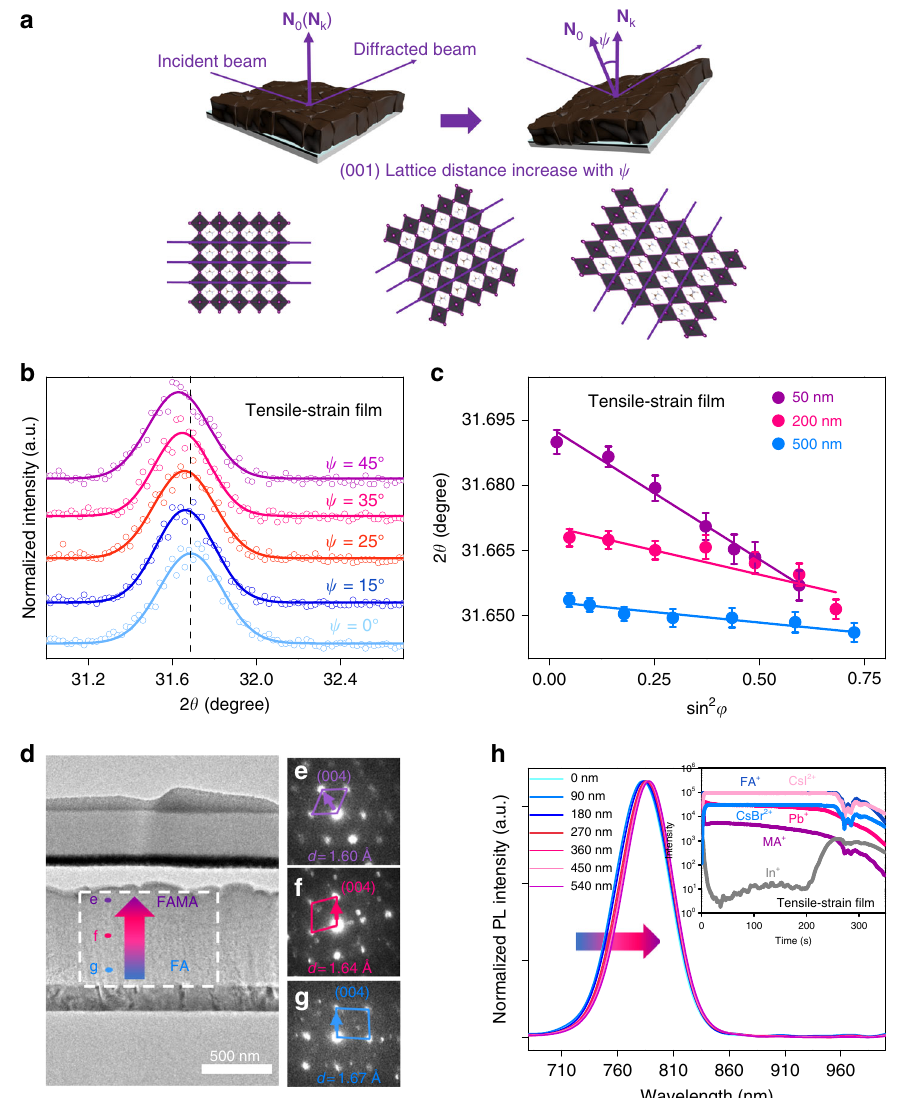
Fig. 1 Gradient lattice structure characterization. a Schematic illustration of the residual strain distribution measurement. The corresponding XRD patterns and lattice structure strain information can be obtained by fi xing the test crystal plane and adjusting the instrument tilt angle ψ , where N 0 is the sample normal direction and N k is the diffraction vector. b GIXRD spectrum at different tilt angles at the depth of 50 nm for the tensile-strained fi lm. c Residual strain distribution in the depth of 50, 200, 500 nm for the tensile-strained fi lm (measured (points) and Gauss fi tted (line) diffraction strain data as a function of sin 2 φ ). The error bar indicates standard deviation of the 2 θ . d The cross-sectional TEM image of device. e , f , g The nano-beam electron diffraction patterns ([100] zone axis and TEM specimens is FIBed), corresponding with e-f-g point in d , con fi rming the FAMA hybrid perovskite phase structure transform to nearly pure FA phase from the surface to the bottom of perovskite fi lm according to the larger quadrangle. h PL depth pro fi le of confocal fl uorescence microscope, the inset represents TOF-SIMS depth pro fi les of the (FAPbI 3 ) 0.85 (MAPbBr 3 ) 0.15 perovskite fi lm with tensile strain.